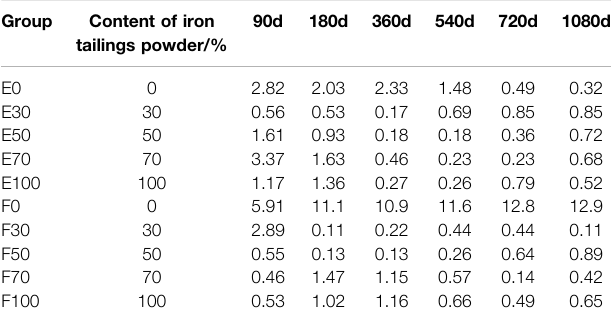
TABLE 12 | Error rate of model calculation value and experiment measured value (%). Group Content of iron tailings